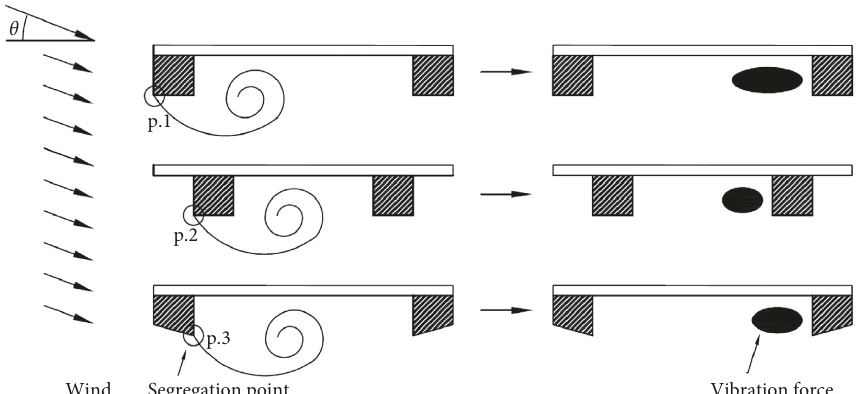
Figure 2: Vortex and vibration generating mechanism of 2-edge box girder: (a) for box slope angle � 0 ° ; (b) for box slope angle � 0 ° with reduced distance between the two boxes; (c) for sloped box